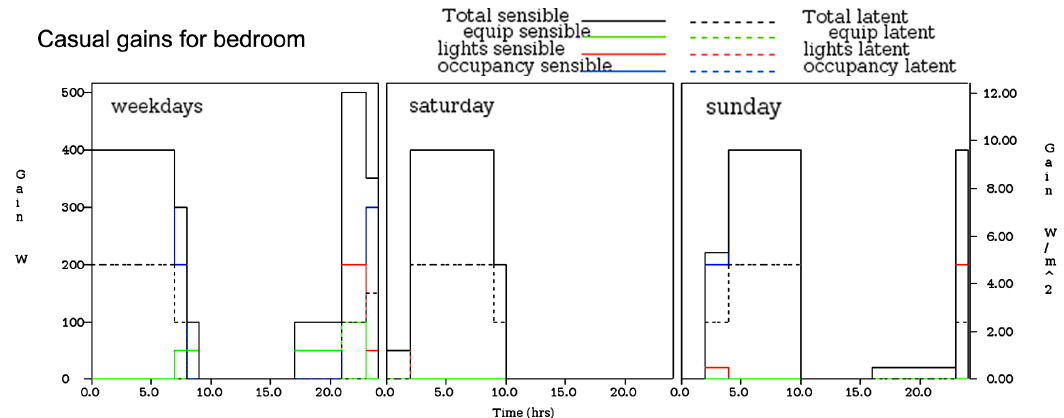
Figure 7. Building model in ESP-r: bedroom casual heat